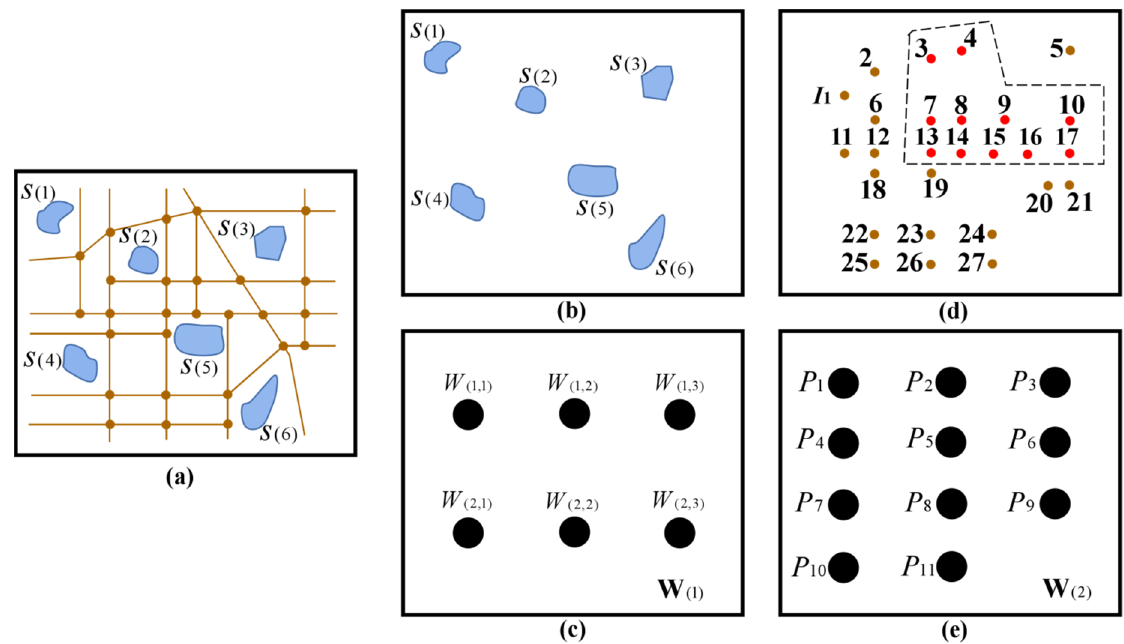
Figure 2. The process of abstracting the tourism space into the model and . ( a ) shows the map of the water scenic spots, the connecting roads and the road intersections. ( b ) shows the distribution of the extracted water scenic spots. ( c ) shows the abstracted water scenic spots in matrix, ( d ) shows the distribution of the extracted road intersections, and ( e ) shows the abstracted road intersections in